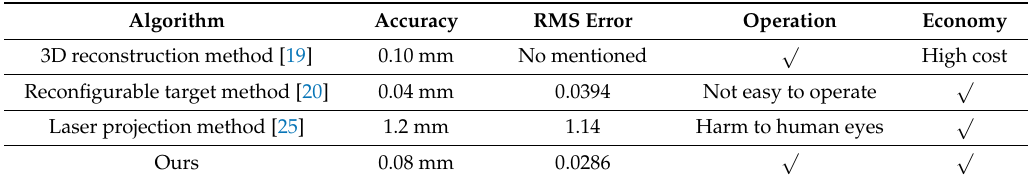
Table 7. Comparison with previous